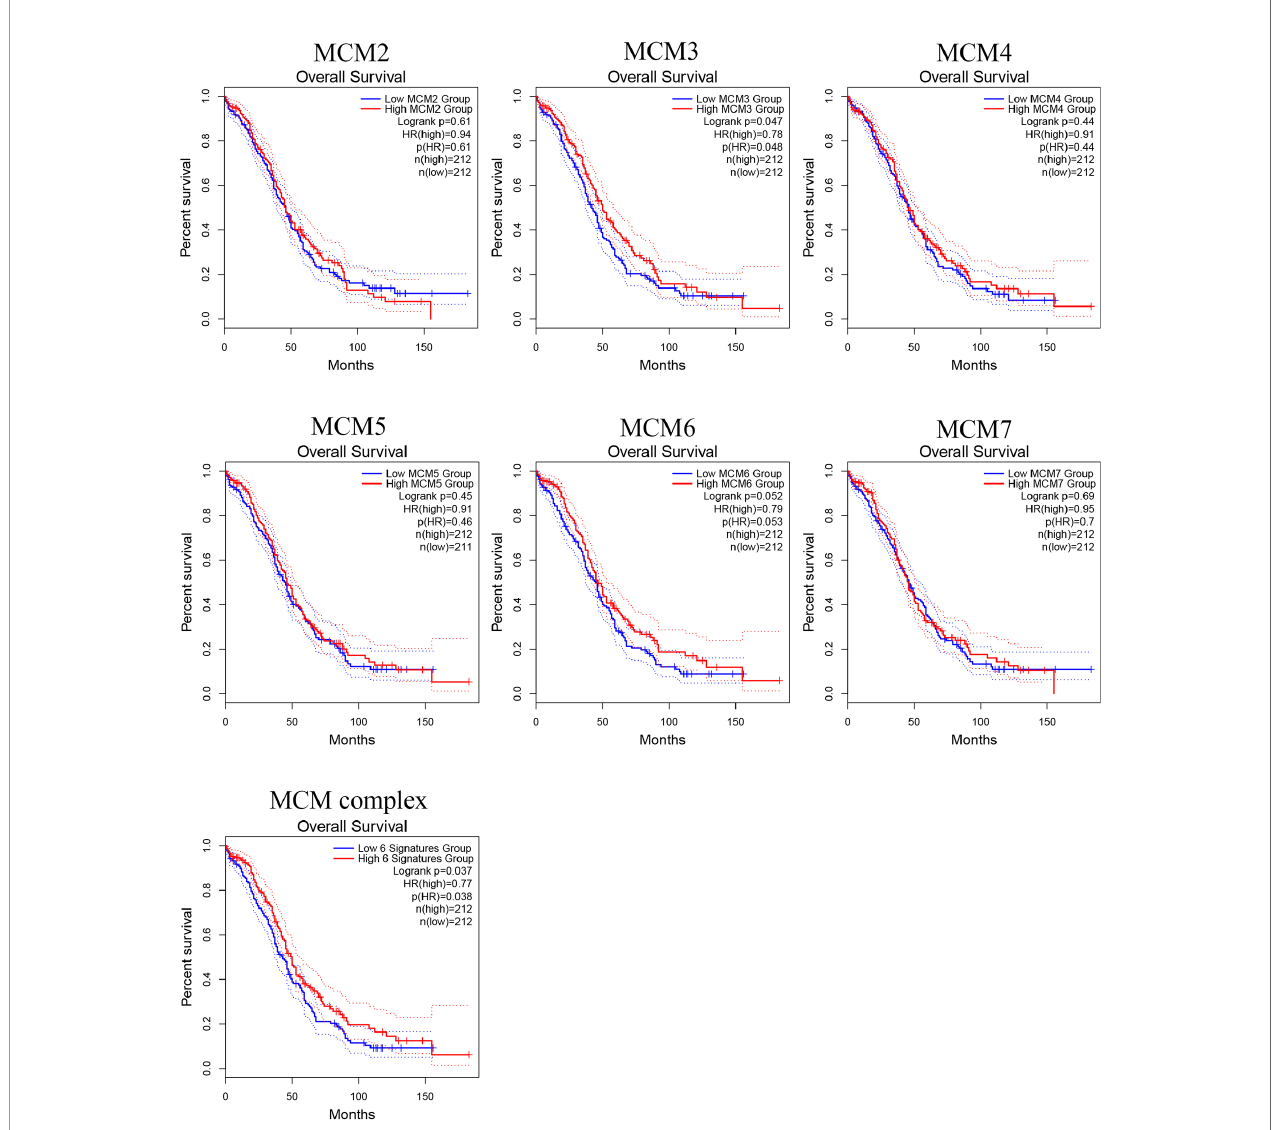
FIGURE 11 | Prognostic value of the MCM complex members in OC. Survival analysis of the MCM2, MCM3, MCM4, MCM5, MCM6, and MCM7 signatures and the six-gene MCM signature in OC patients based on the GEPIA